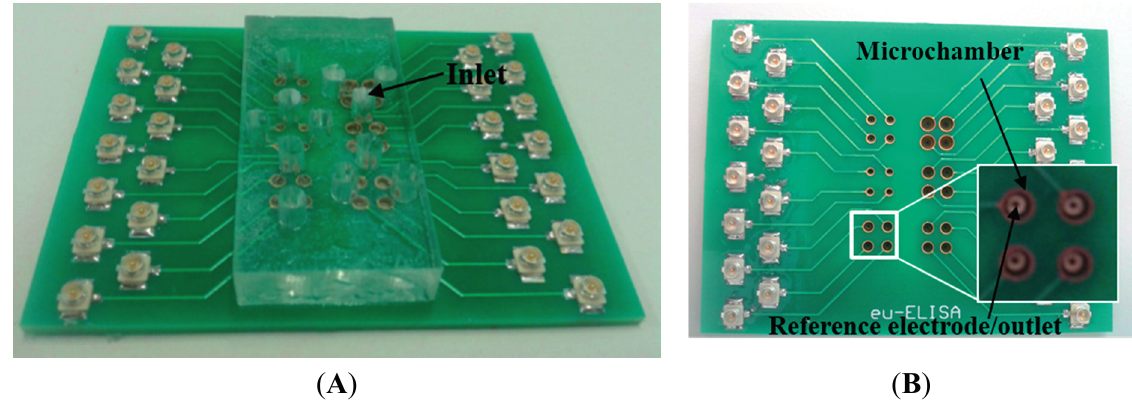
Figure 7. ( A ) Lab-on-PCB (Printed Circuit Board) integrating PMMA (Poly-methyl methacrylate) microfluidics and PCB microchambers and reference electrodes. ( B ) Two layer PCB before the attachment of microfluidics, comprising PCB reference electrodes in the bottom layer and microchambers in the top layer.